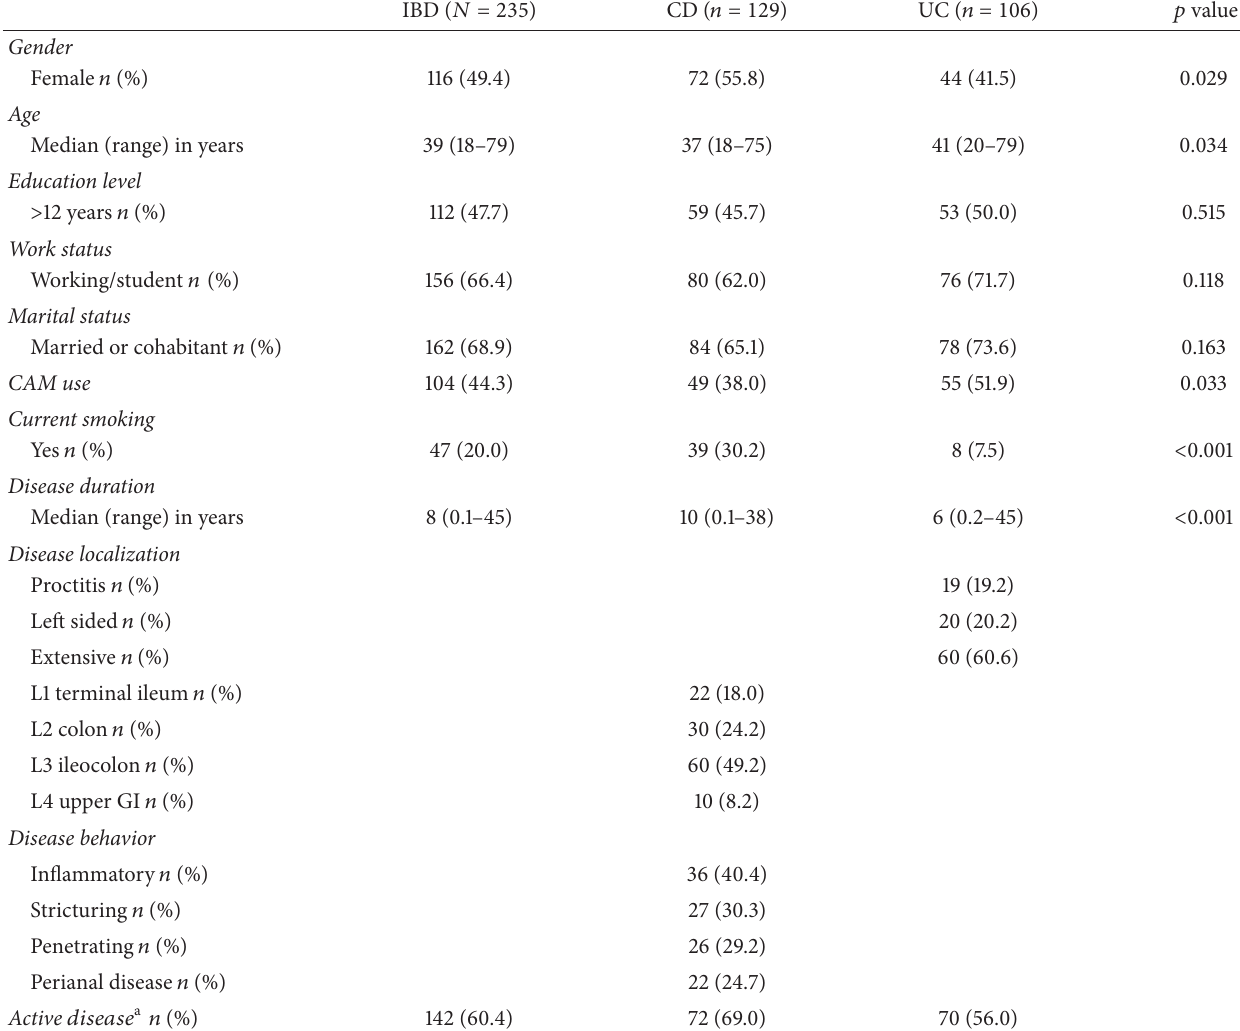
Table 2: Comparison of sociodemographic and clinical characteristics of the study